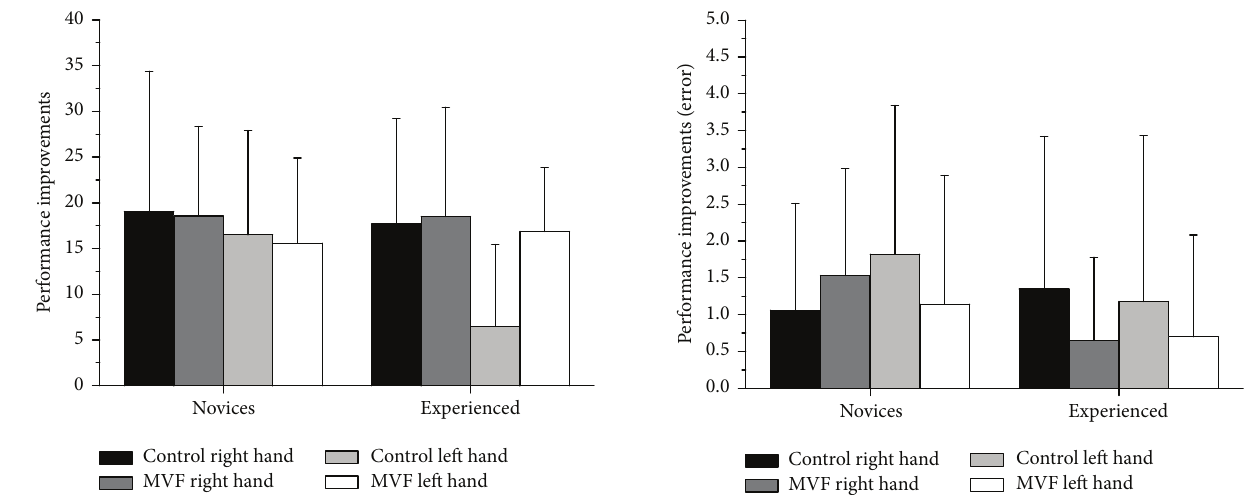
Figure 3: Shown are the performance improvements for the main outcome variable (dribbling performance) calculated by subtracting prevalues from postvalues and separated for novice and experienced groups. Scores depicted are absolute means, and error bars indicate standard deviations. The higher the value, the greater the improve- ment; statistics are explained in the text.